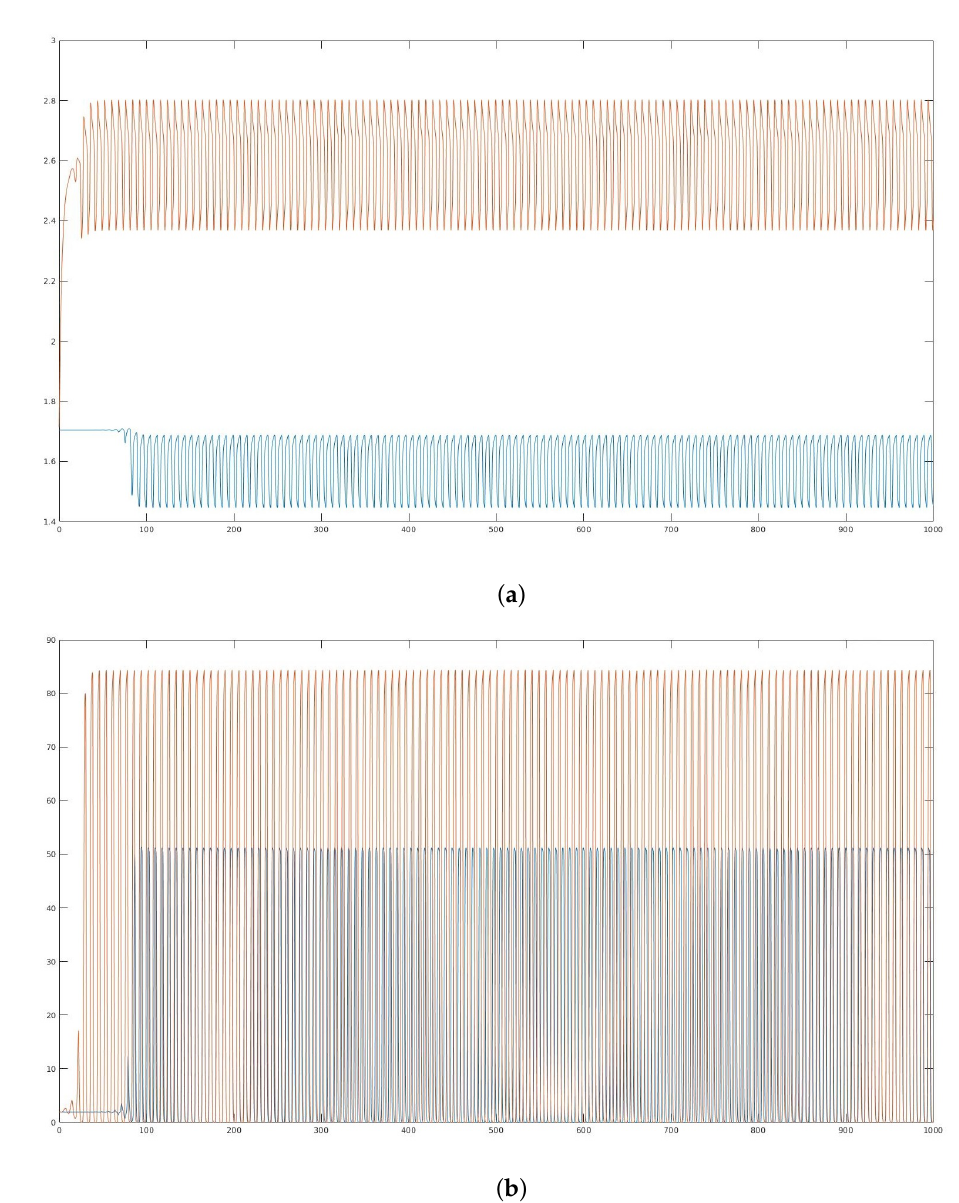
Figure 4. Stability of equilibrium point ˜ E 2 : ( a ) Evolution of the white blood cells’ precursors; ( b ) Evolution of the adult